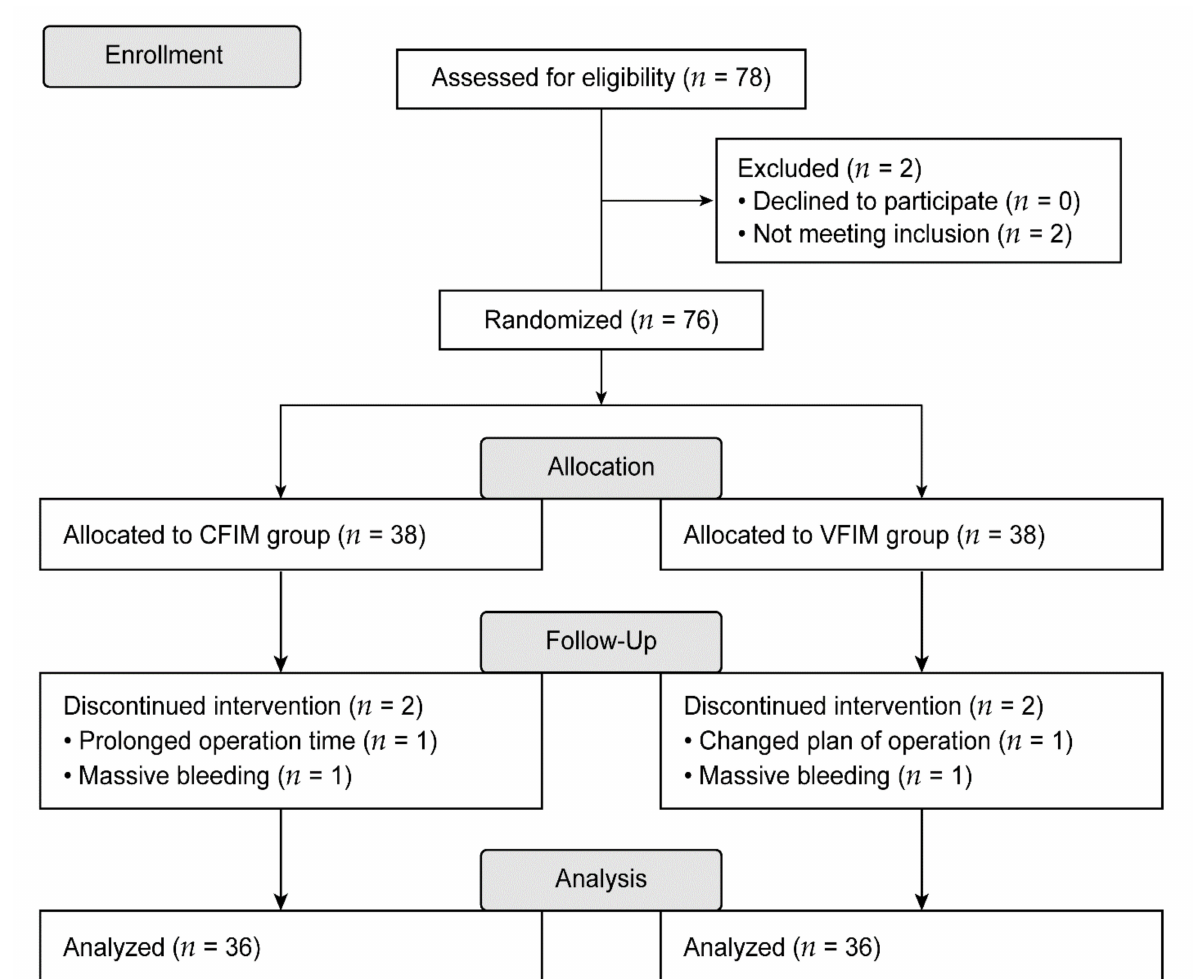
Figure 1. Flow diagram depicting patient enrollment. CFIM, conventional fixed-rate infusion mode; VFIM, variable-rate feedback infusion